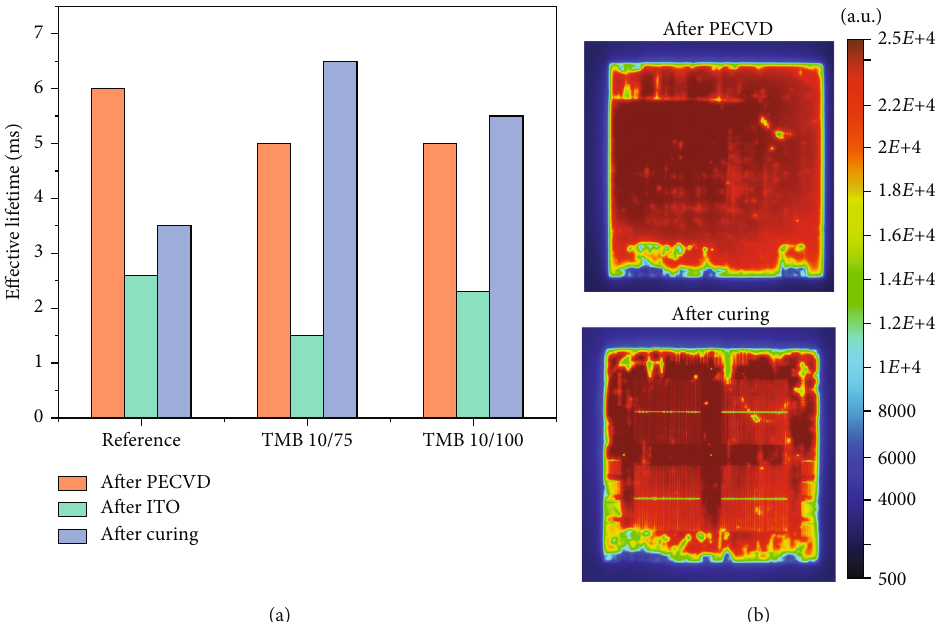
Figure 8: (a) E ff ective lifetime at the injection level of 10 15 cm -3 for 3 di ff erent splits (as described in Table 4), after di ff erent processing steps, namely, PECVD, ITO sputtering, and curing after Ag screen printing. (b) Uncalibrated PL images of a wafer (reference split) after PECVD and after curing, exhibiting similar levels of passivation.